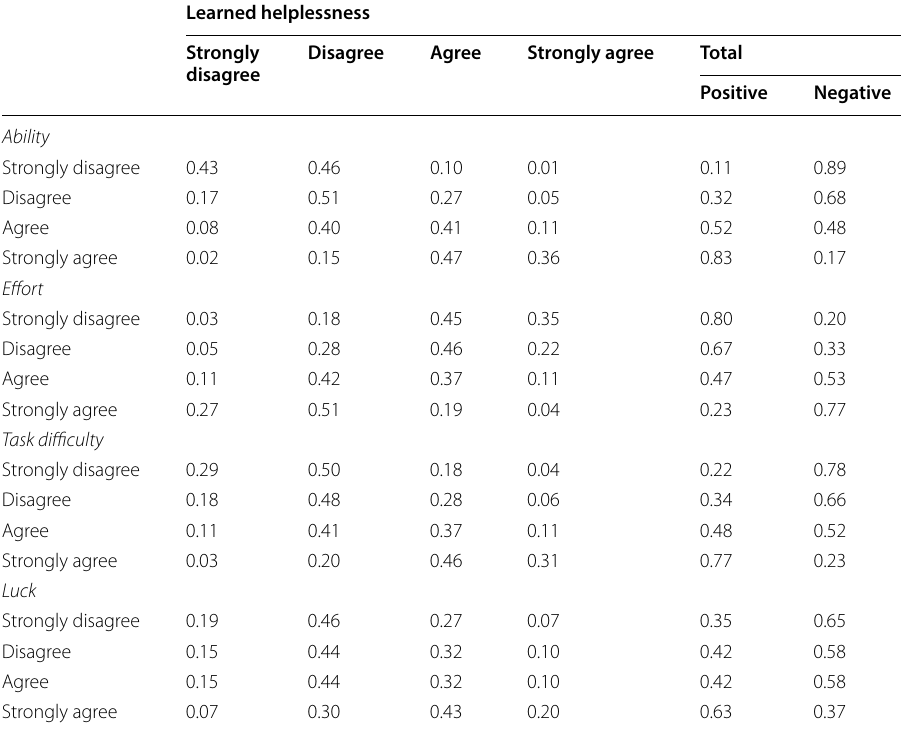
Table 6 Korean students’ probability to agree/disagree with learned helplessness by